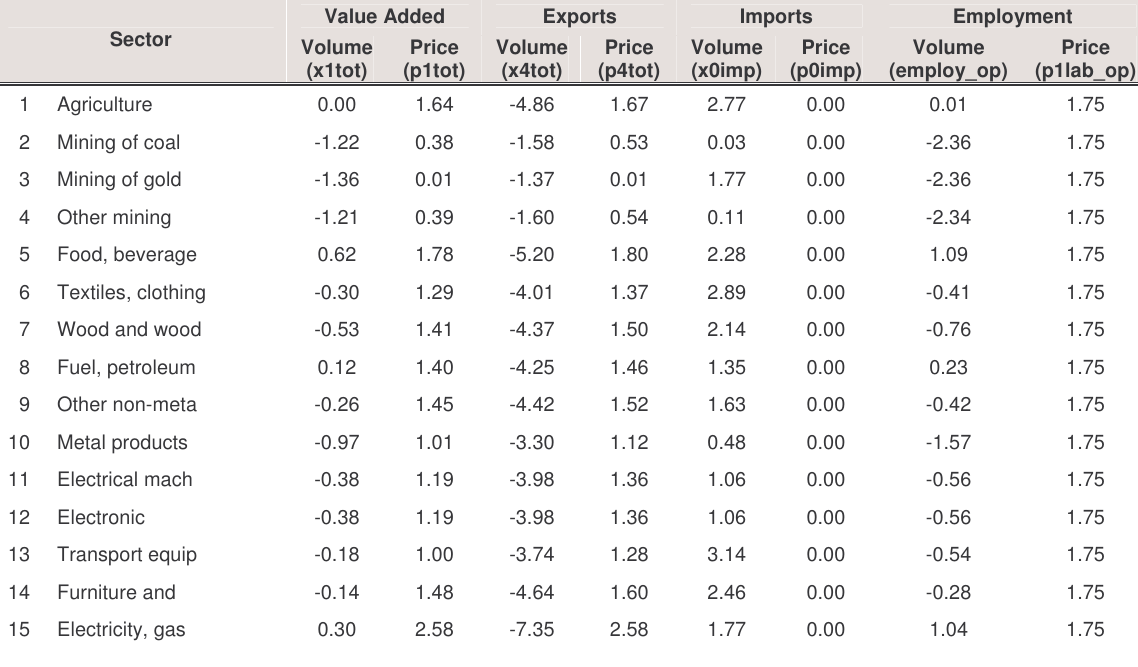
Table 4: Sector results for scenario 2 (structural